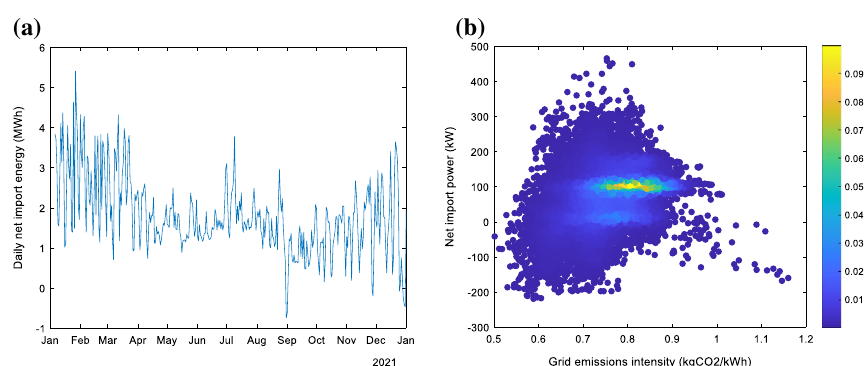
Fig. 9 a Daily net import energy and b scatter plot of net import power vs grid emission intensity coloured by frequency for the case study site.